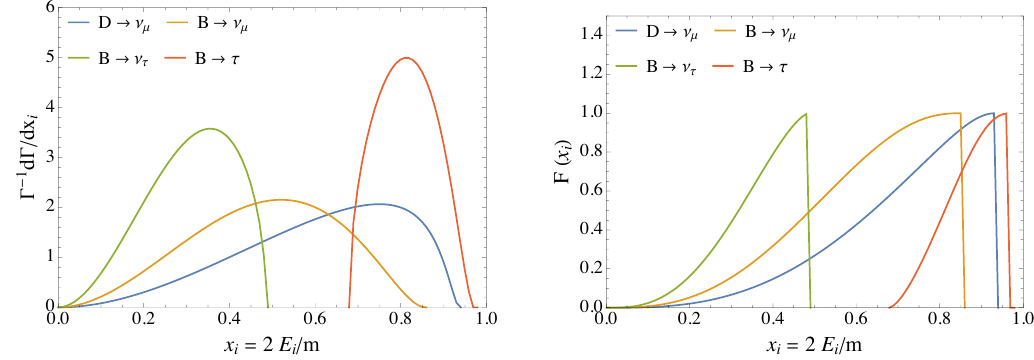
Figure 16 . Left panel: the fractional energy distributions x i = E i = ( m= 2) in three-body semi- leptonic decays in the rest frame of the decaying heavy particle with m = m D i = (cid:23) (cid:22) ; (cid:23) (cid:28) and (cid:28) . Right panel: the cumulative distribution function for each of the three-body decays shown in the left